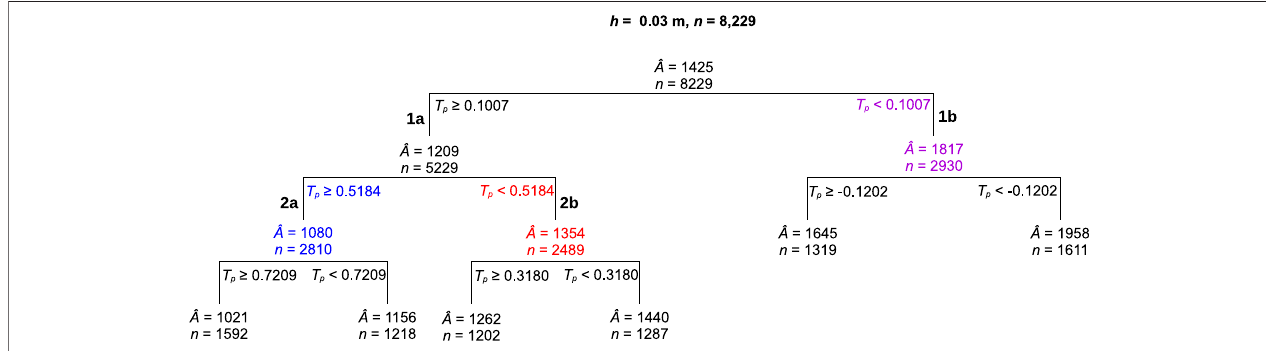
FIGURE 5 | Recursive partition tree of annual ablation predicted in the Monte Carlo simulations with debris thickness of 0.03 m. The median values of ^ A , and the number of predictions in each cluster, n , are printed together as a leaf at the end of the branches of the tree. The partitioning parameters and partition values are printed belowthe branches. Colours and labels identify clustersofparameter sets that were used infurtheranalysis;numbers indicate the order ofabranch, and letters indicate the relative direction of a limb.